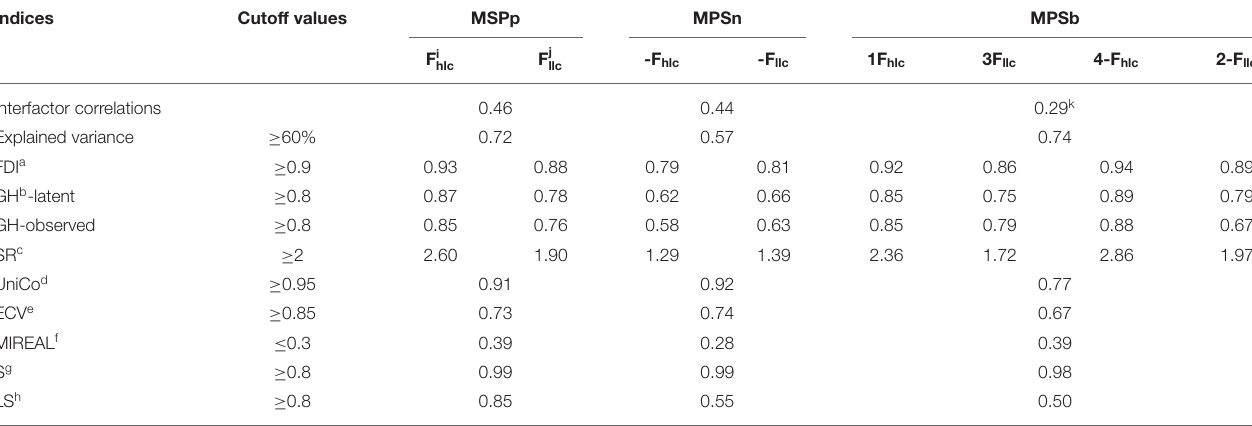
TABLE 3 | Indices to assess the quality of EFA factor solutions. Indices Cutoff values MSPp